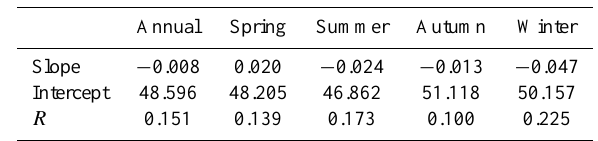
Table 4. Linear regression coefficients of annual and seasonal clear- ness index from 1981 to 2010 for annual clearness index.